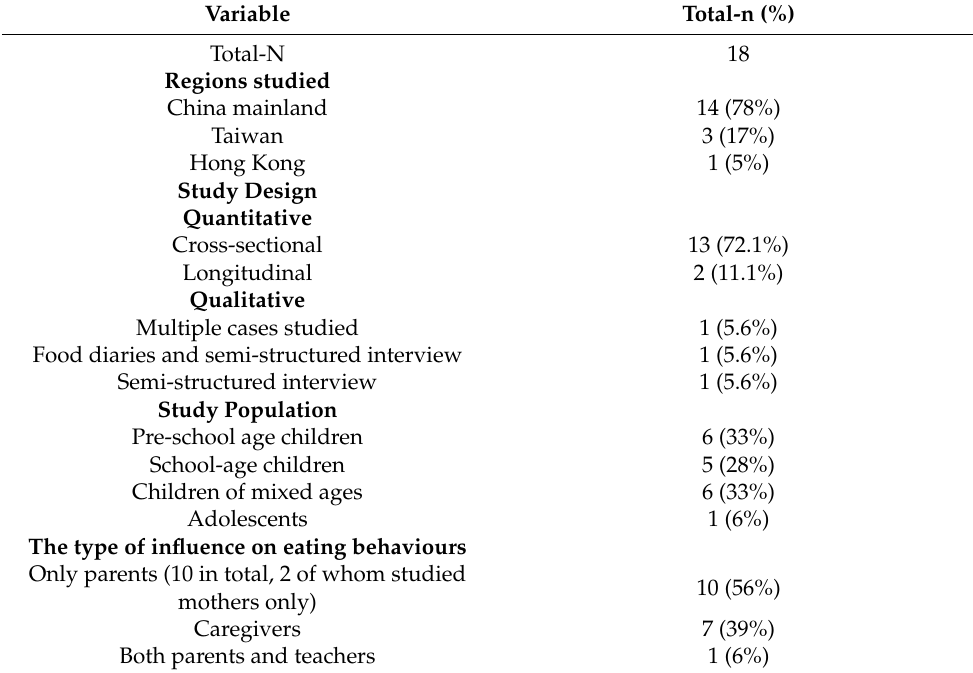
Table 1. Descriptions of the included